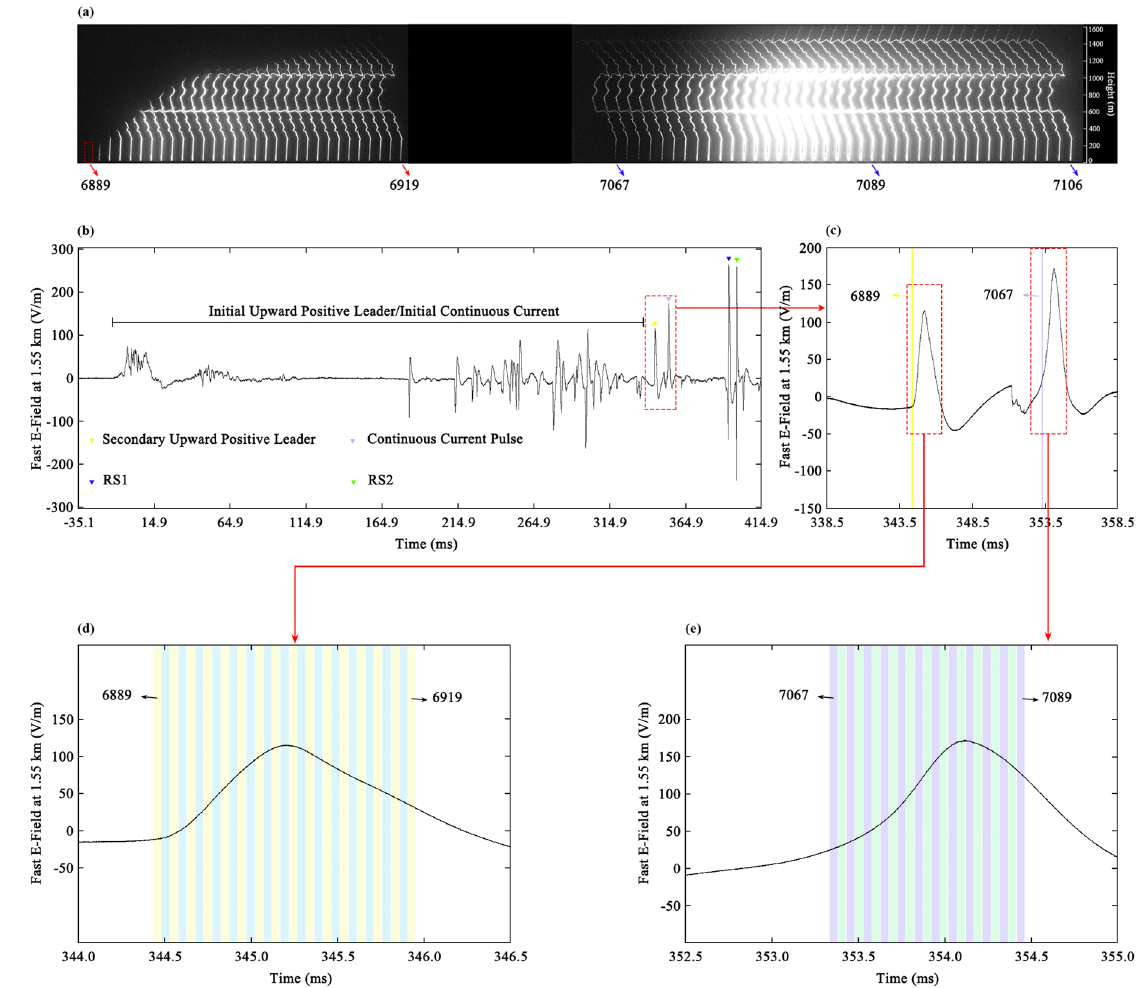
the position of SUPL, SCCP, RS1 and RS2. The high-speed frames are represented by these yellow-and-cyan and purple-and-green rectangles respectively to match with the corresponding electric field changes with an uncertainty of 3.8